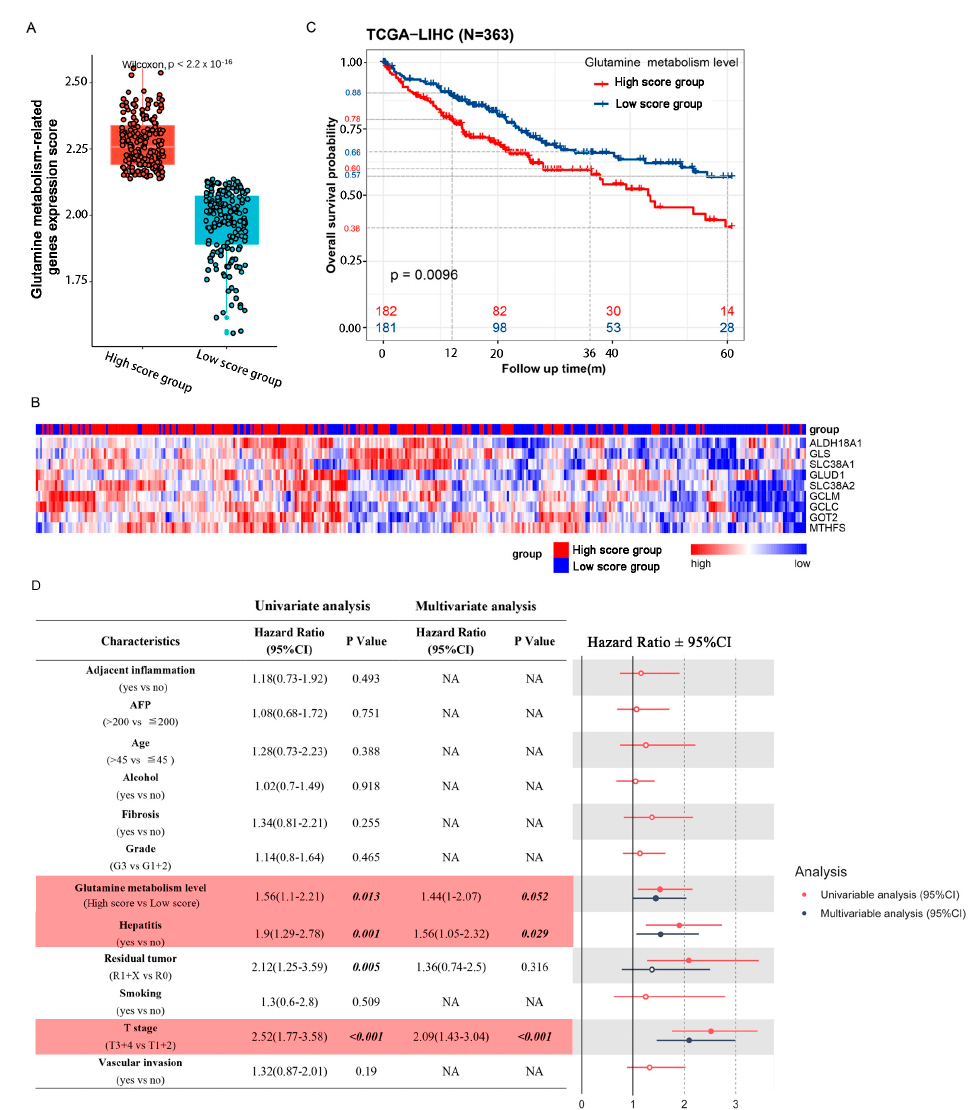
Figure 1. Glutamine metabolic activity of tumor tissue is associated with patient prognosis. ( A ) 363 pa- tients of a TCGA cohort could be divided into 2 groups according to the median value of glutamine- metabolism-related gene expression scores. ( B ) Expression levels of individual genes (ALDH18A1, GCLC, GCLM, GLS, GLUD1, GOT2, MTHFS, SLC38A1 and SLC38A2) are displayed as a heatmap, with low expressions in blue and high expressions in red. The left side of the heatmap shows patients with high scores and the right side shows patients with low scores. ( C ) Kaplan–Meier analysis shows that patients with high scores suffered a worse overall survival rate. Numbers of patients and risk classifications are indicated in the figure. Significance was calculated using the log-rank test. ( D ) CPHR analysis results of glutamine-metabolism-related gene expression scores and clinical factors. The forest on the right shows the results of the univariate and multivariate analyses, with reference value of the hazard ratio = 1. Line intersection with reference line suggests no statistical difference. Red represents univariate analysis, and blue represents multivariate analysis.